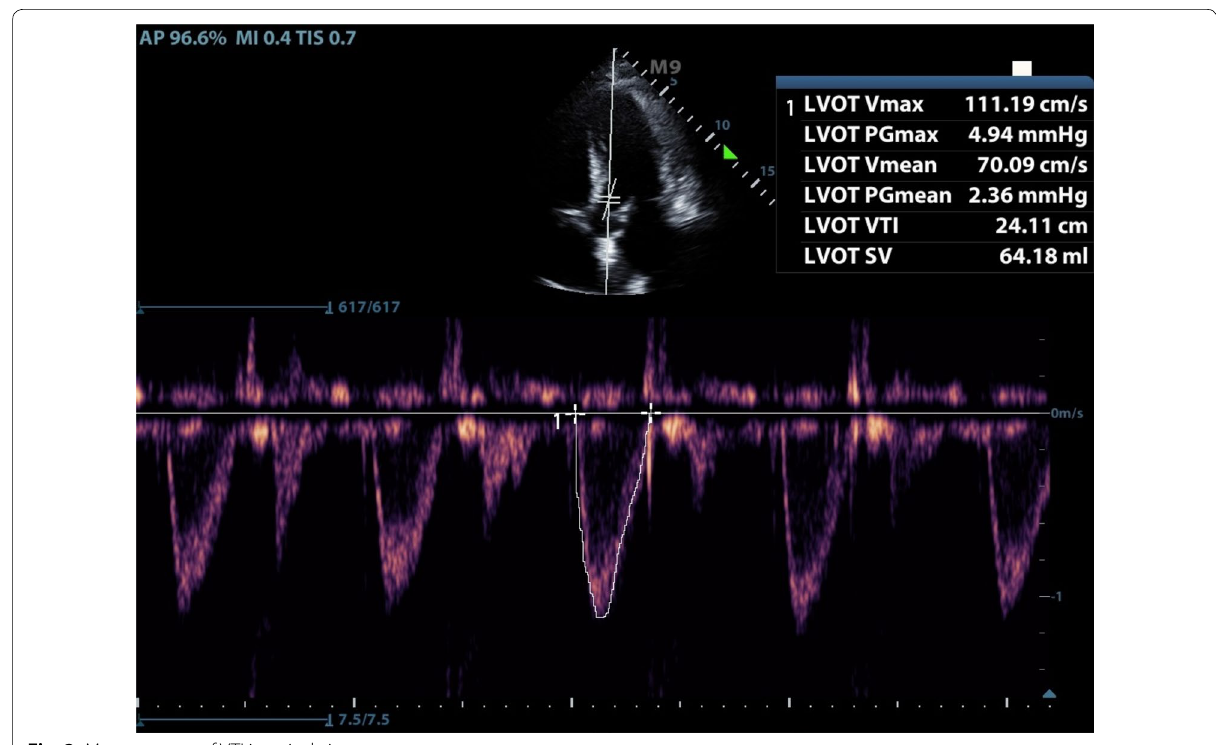
Fig. 2 Measurement of VTI in apical